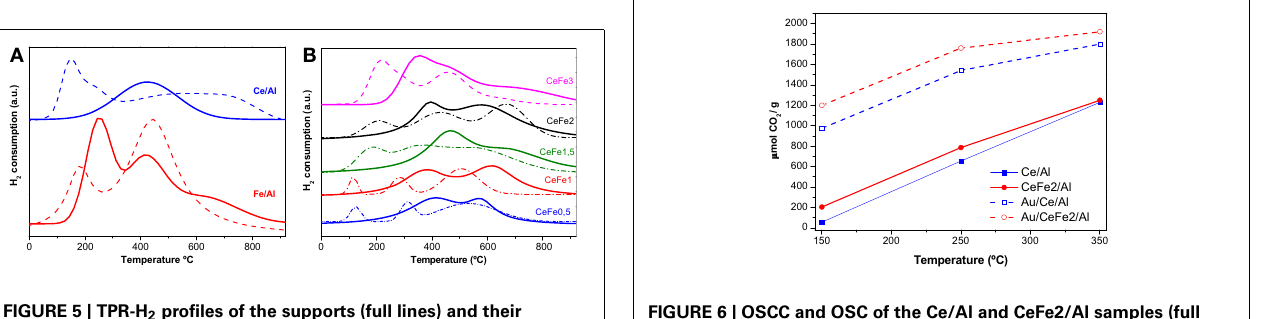
FIGURE 6 | OSCC and OSC of the Ce/Al and CeFe2/Al samples (full symbol and lines) and Au containing analogues (empty symbols dashed